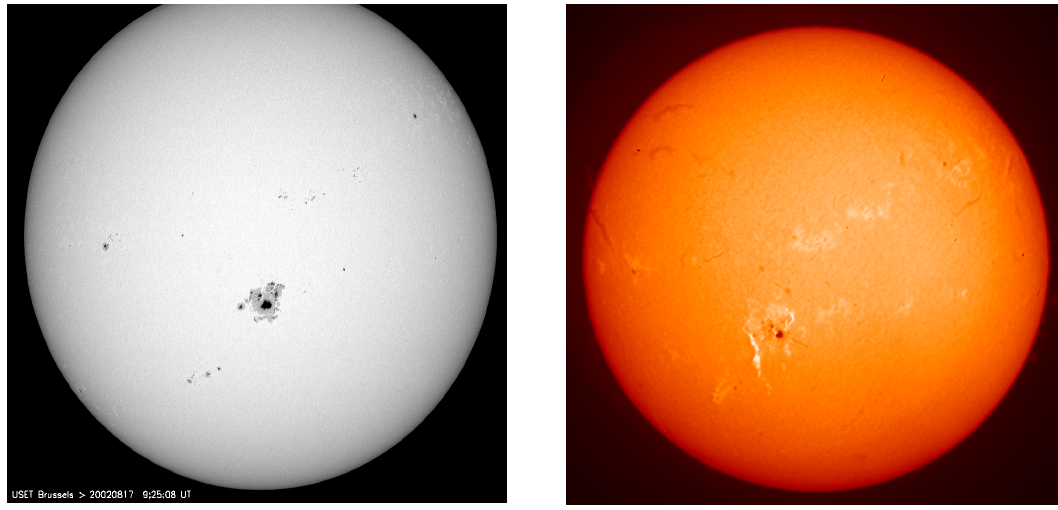
Fig 1: Left: white-light USET image (2002/08/17) featuring the giant sunspot group NOAA10069. Right: H (cid:1) USET image (2002/08/16) showing an M5.2 two-ribbon flare in active region NOAA10069 Fig. 1. Left: white-light USET image (17 August 2002) featuring the giant sunspot group NOAA10069. Right: H α USET image (16 August 2002) showing an M5.2 two-ribbon flare in active region